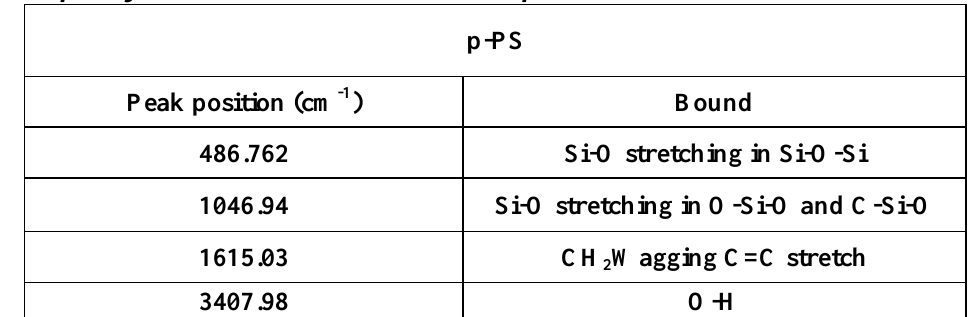
Fig.4: FTIR transmittance spectrum for PSi (n-type) at (20 mA/cm 2 ) and etching time (10min). Table 3: Wavenumber positions and bonds of the transmittance peaks observed in several PS samples by Fourier transform infrared absorption FTIR